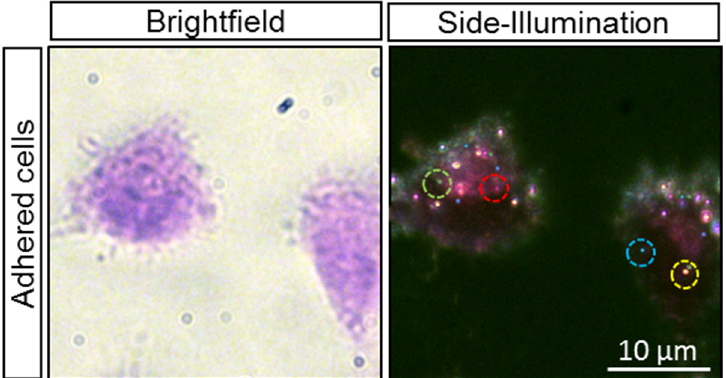
Figure 7. The representative bright-field and dark-field SI images of multiplexed MDA-MB-453 ad- herent cells stained with Gill II hematoxylin and eosin B. adherent cells stained with Gill II hematoxylin and eosin